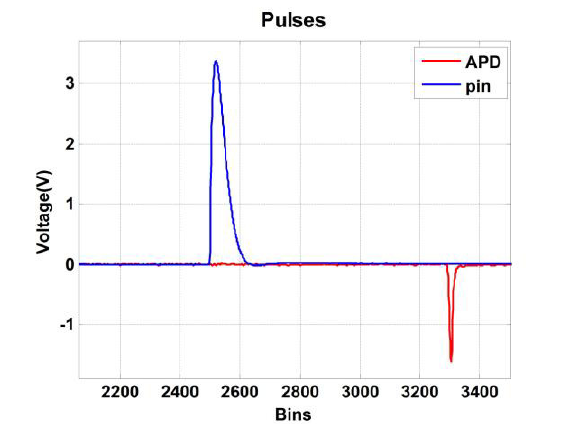
Figure 5 Single pulse echo and energy monitor signals waveform